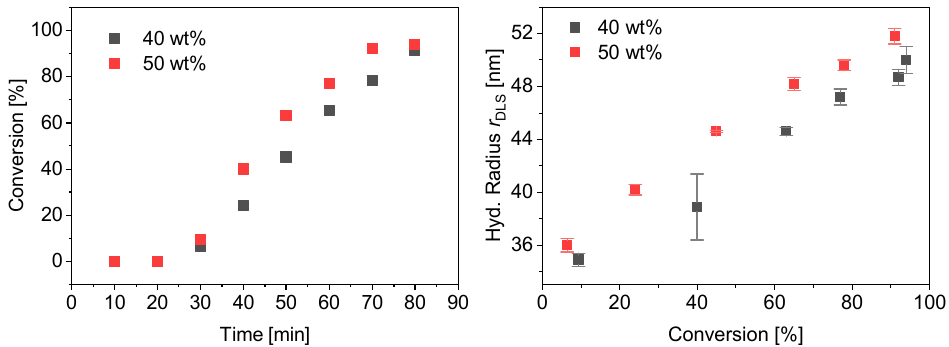
Figure 10. Conversion vs. time data for PMAA 20 - b -PS 8018 with CTA3 at 40 wt% and 50 wt% ( left ) and average hydrodynamic radius measured by DLS against the conversion ( right ).